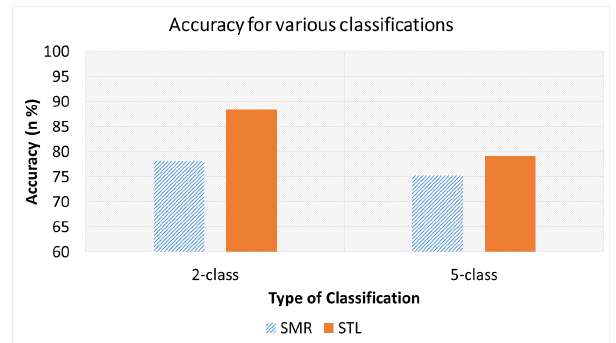
Figure 3: Classification accuracy using self-taught learning (STL) and soft-max regression (SMR) for 2- Class, 5-Class, and 23-Class when applied to training data